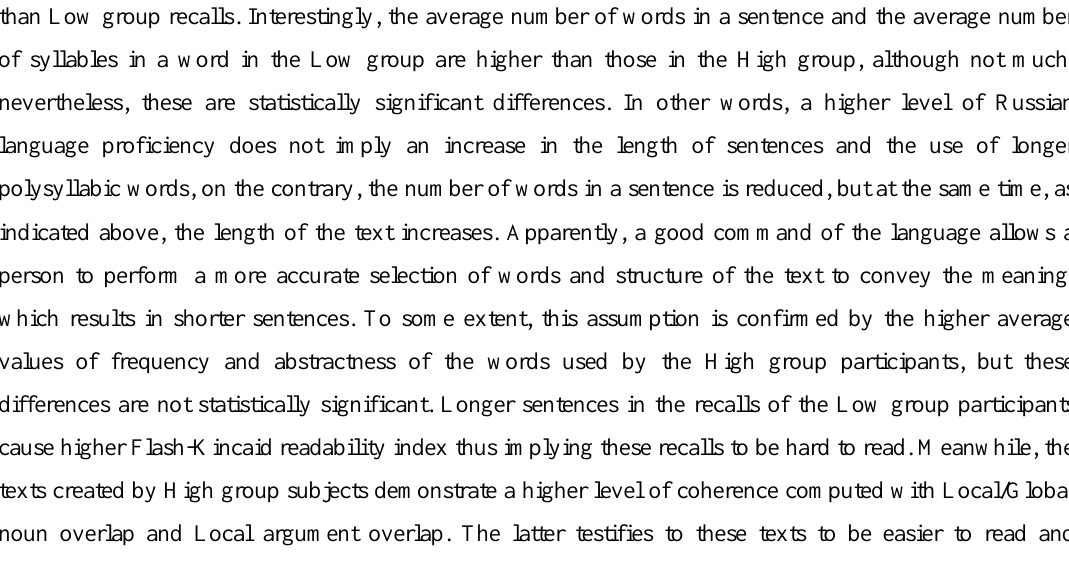
Table 6. Mann-Whitney Test for Participants Assigned to the Low and High Comprehension